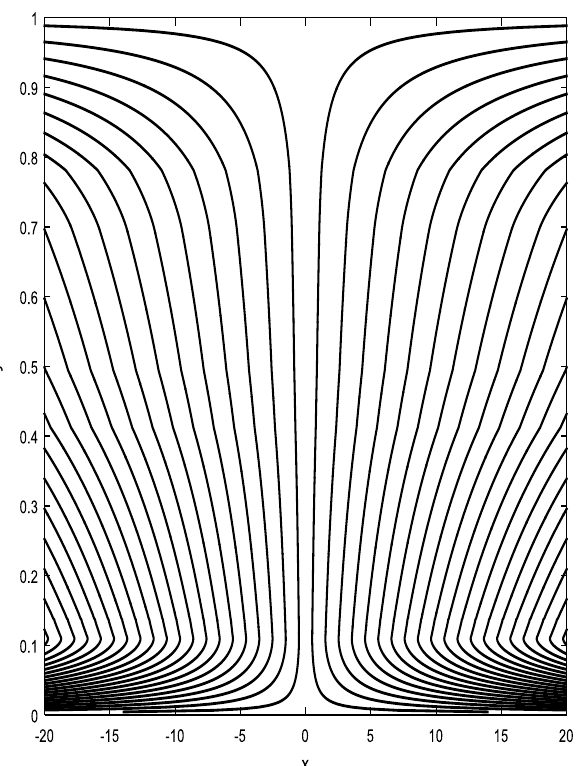
Figure 36. Stream lines profile at F = 0.6 and M = 1.5.